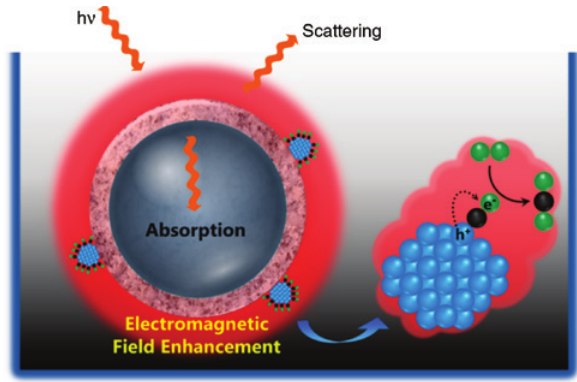
Figure 9: Schematic illustration of the plasmon-enhanced CO oxidation catalysis using Ag@SiO /Pt core/shell/shell NPs. 2 The optimal performance is observed in the intermediate Ag size regime (25–50 nm) associated with the suppressed far-field scattering and enhanced near-field energy transfer (PIRET). Adapted with permission from Ref. [60]. Copyright 2017 American Chemical Society.